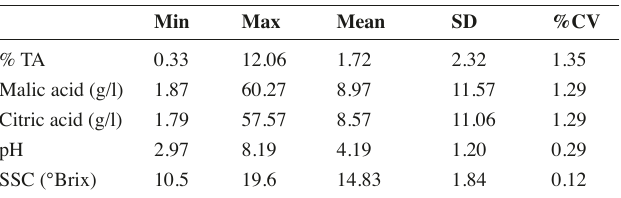
Tab. 3: Descriptive statistics for the variables of sucrose, glucose, xylose, fructose, total sugars, sucrose between glucose and glucose between fructose of the 34 local accessions studied. For each trait, minimum, maximum and mean values and standard deviation (SD) are present-